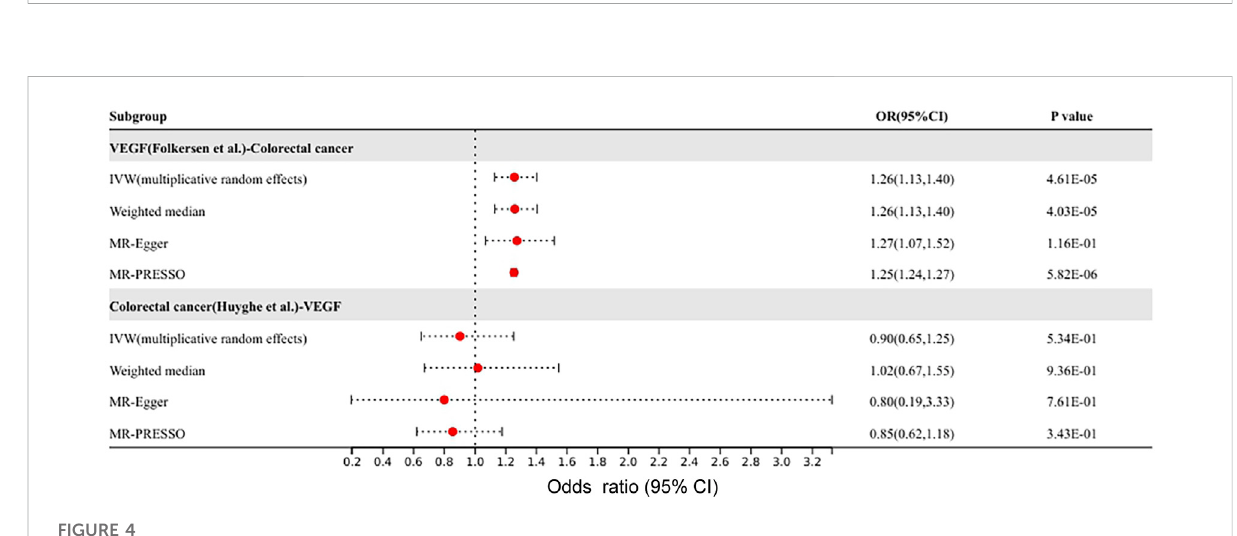
Different GWAS data to verify the causal effect between VEGF and colorectal